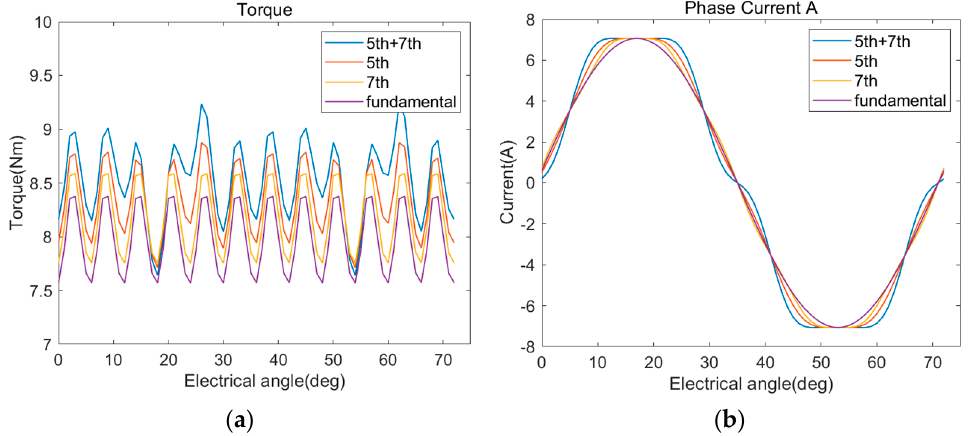
Figure 8. Torque and stator current calculations via FEM at 5 Arms: ( a ) torque; ( b ) phase current A. Table 3. FEM simulation results for phase stator current and output torque according to harmonic injection methods.